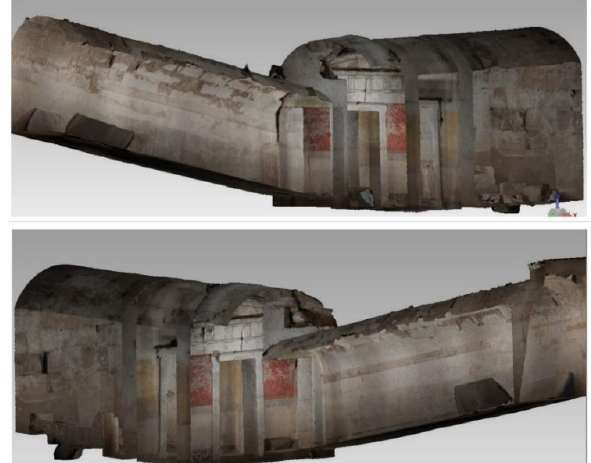
Figure 9: 3D model creation of the Macedonian tomb of Heuzey Thirdly, the point cloud from Faro Scene and the dense point cloud from Photoscan were combined to create the final 3D model of the tomb. These point clouds were imported into the Geomagic ® Studio software to be merged in order to fill eventual gaps. Then, following the automated software steps a surface (wrap) of the tomb is created. At this point, it was decided to remove the modern shelter with the railings from the final model, as it was incomplete and contained misleading information. Of course, as it is a modern construction its removal does not affect the ancient construction.